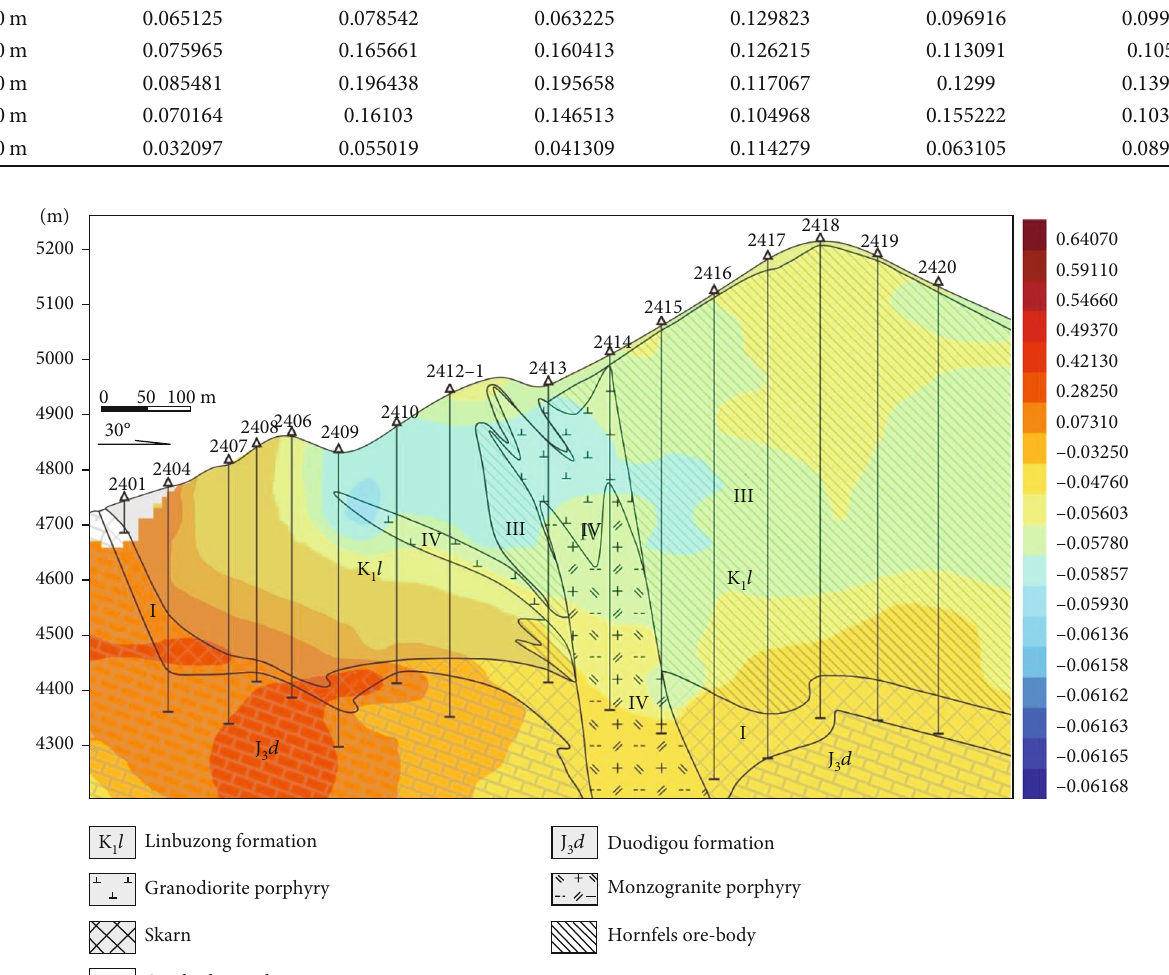
Figure 6: Results of integrated geochemical mapping using